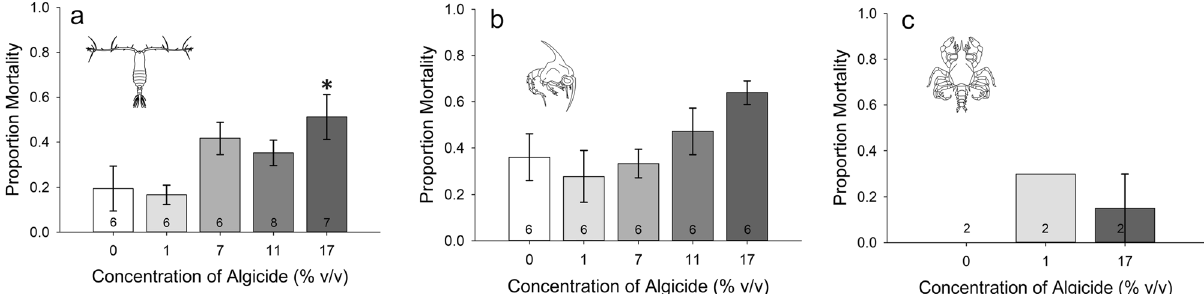
Figure 2. Mortality of invertebrate taxa during LAM experiments; mortality was assessed after 24 h in clean water following a prior 24-h algicide exposure. ( a ) Mortality of A. tonsa adult females. Only the 17% concentration had statistically higher mortality than the control (one-way ANOVA on Ranks, p = 0.012; Dunn’s test post-hoc, p = 0.040). Mortality of C. sapidus zoeae ( b ) and megalopae ( c ). Neither crab life stage had statistically significant mortality compared to the control for any algicide concentration tested ( p > 0.05). (* p < 0.05).